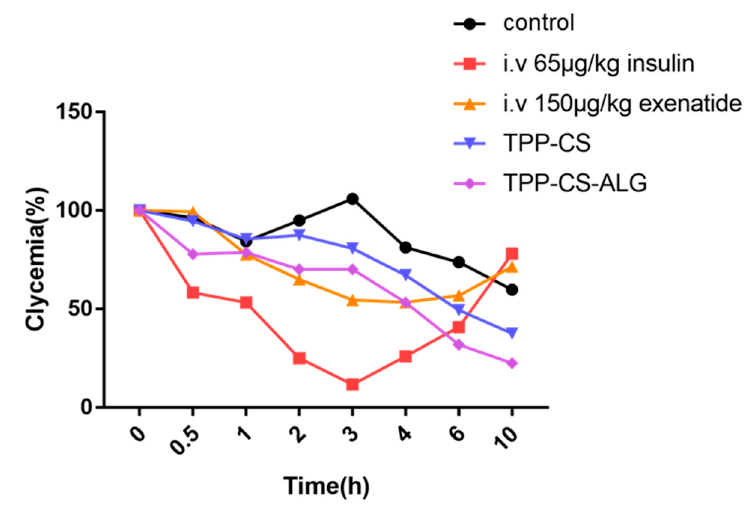
Figure 6. Pharmacodynamics of exenatide in rats with SC injection of exenatide solution at a dose of 150 µg/kg and oral administration of various formulations at a dose of 650 µg/kg.